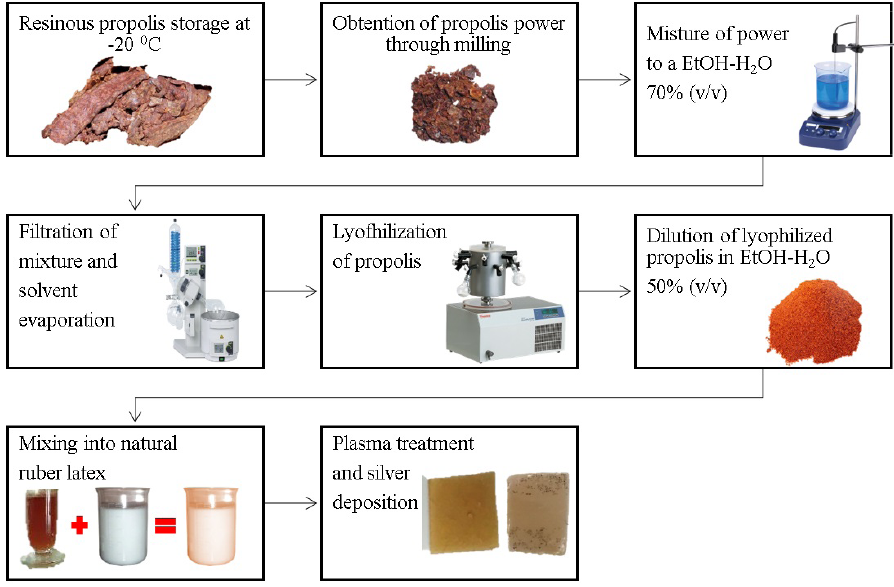
Figure 1. Flow chart for the methodology adopted in the preparation of NRL-RP films.